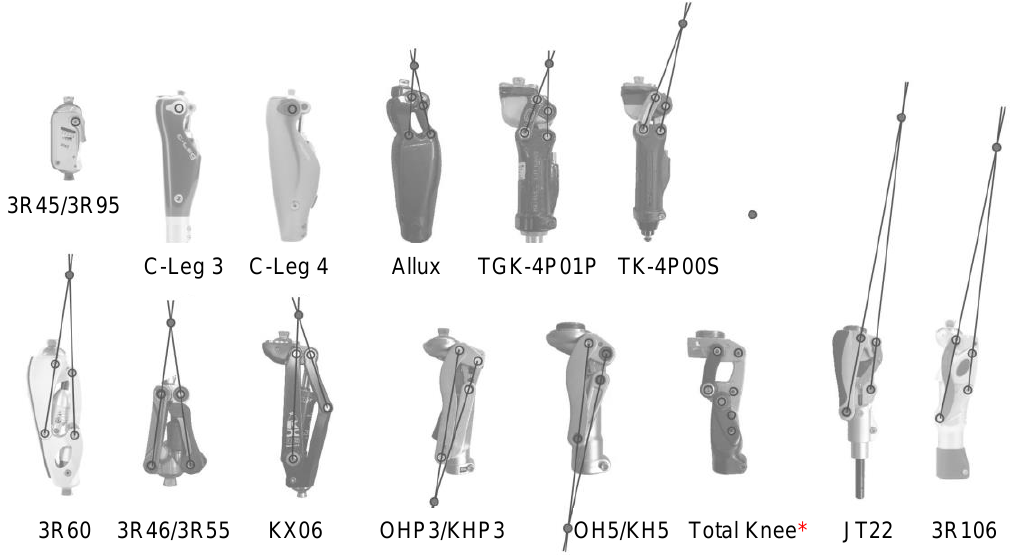
Figure 1: Polycentric and monocentric knee joints investigated with schematic illustration of the ICR respectively (scaling is not uniform between the knee joints), *according to Van de Veen PG ,2001.